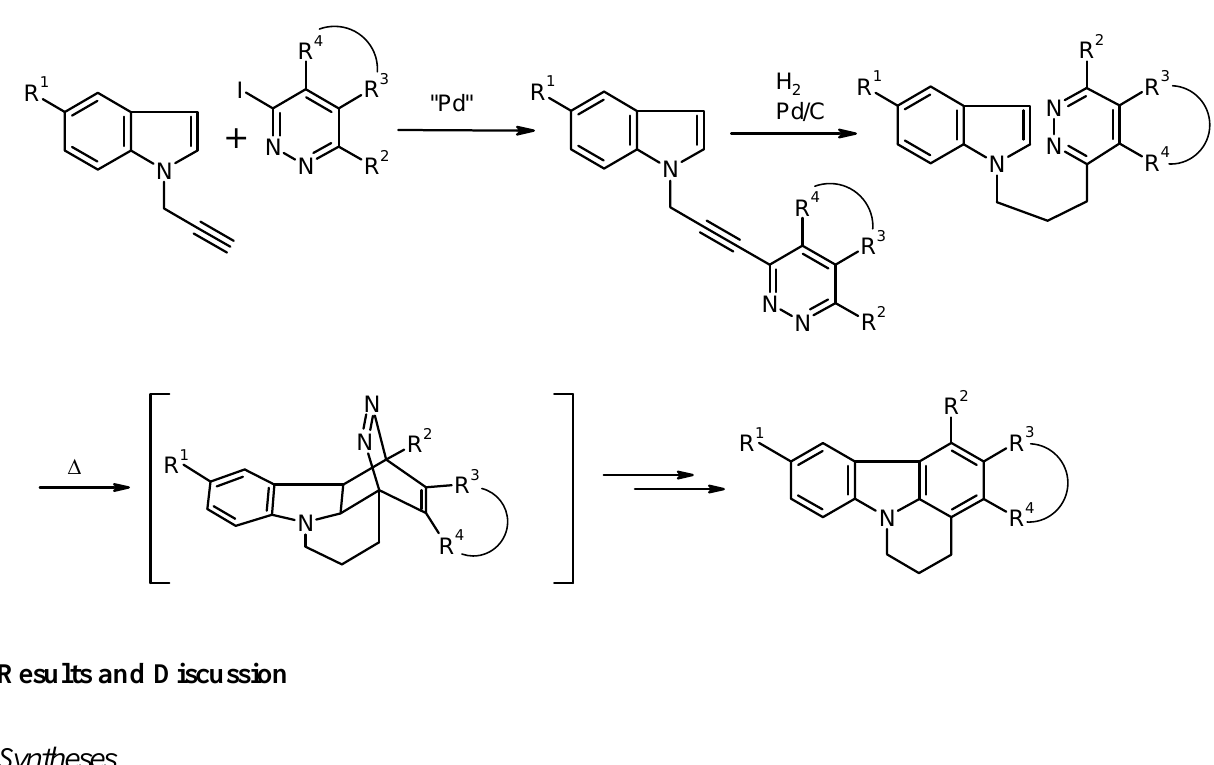
Scheme 1. Synthesis of bridged ellipticine/olivacine analogs